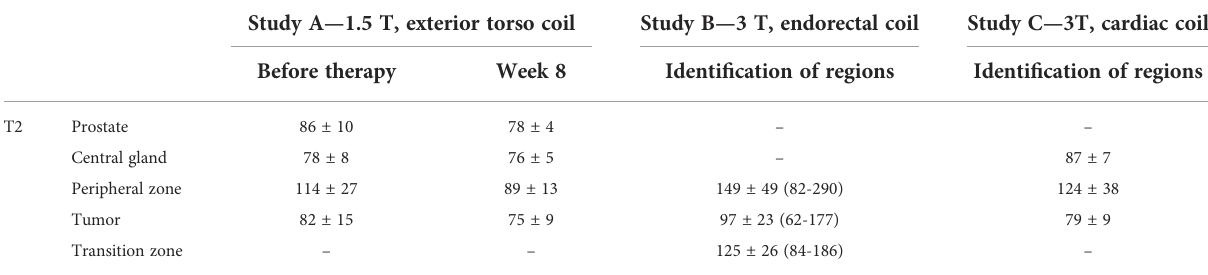
TABLE 6 T2 values reported by prostate studies.